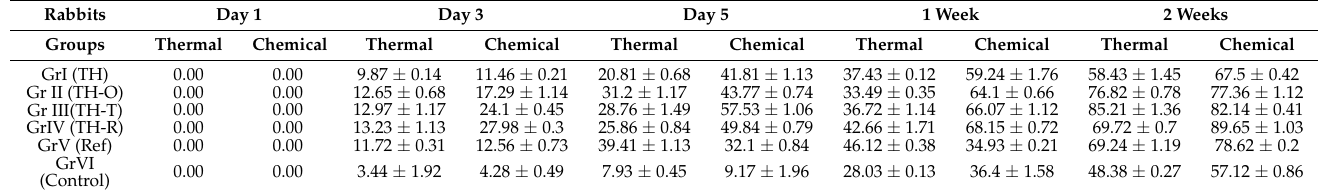
Table 9. Effects of Thymus vulgaris honey and mixtures on wound contraction (%).